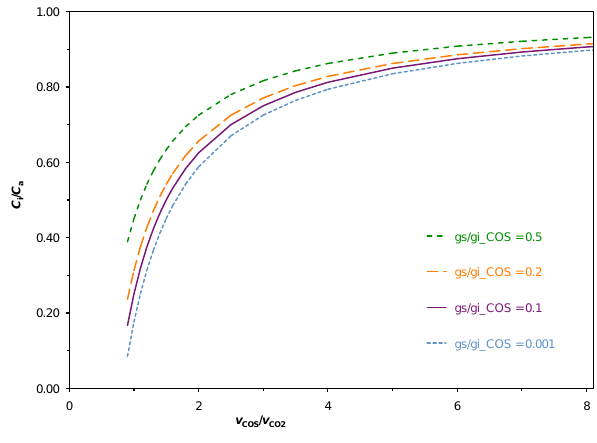
Fig. 3. Ratios of intercellular to ambient CO 2 mole fraction, C i / C a , can be obtained from the normalized uptake ratios of COS to CO 2 , v COS /v CO , based on Eq. (9) and R c − COS =1.2. We assume that 2 leaf internal conductance is much higher than stomatal conductance ( g s COS /g i COS =0.1 or 0.2). Thus, neglecting this component (i.e. assigning a value of 0.001) does not make a large difference com- pared to including it. It is also possible that g i COS is a more limit- ing part of the diffusional pathway (0.5), with a narrower range of v COS /v CO corresponding to typical C i / C a 2